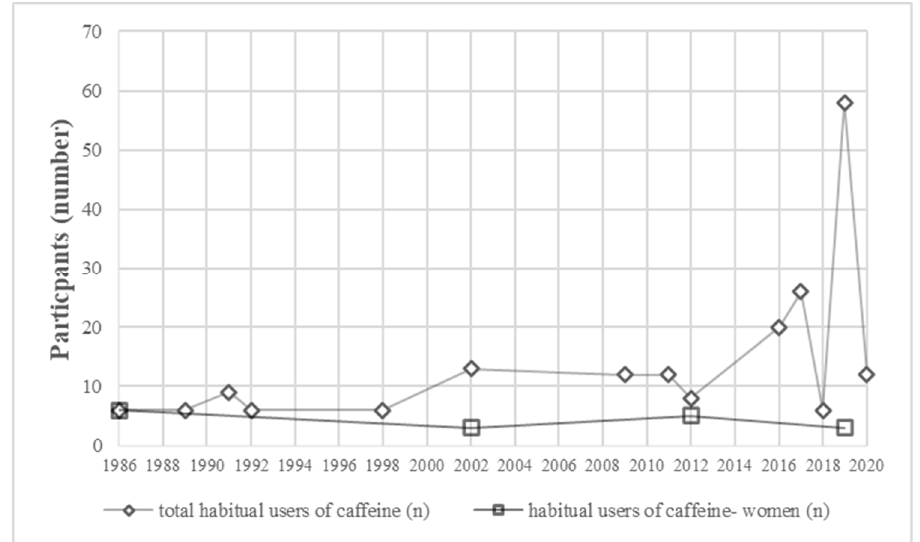
Figure 2. Number of participants habituated to caffeine included in research on the ergogenic effects of acute caffeine intake.